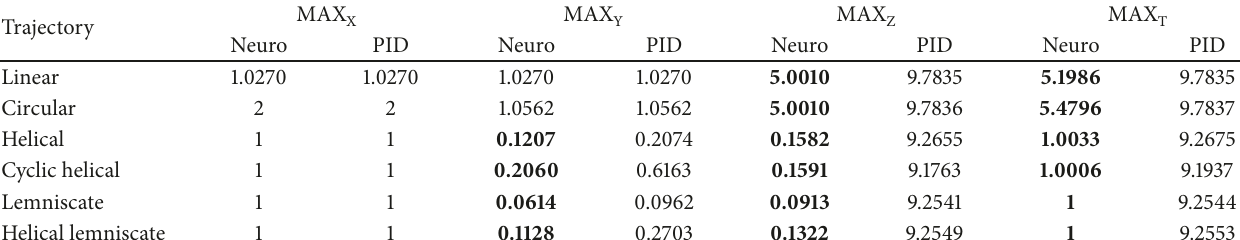
Table 4: Comparison of the MAX of the tracking error for different trajectories with mass variation.